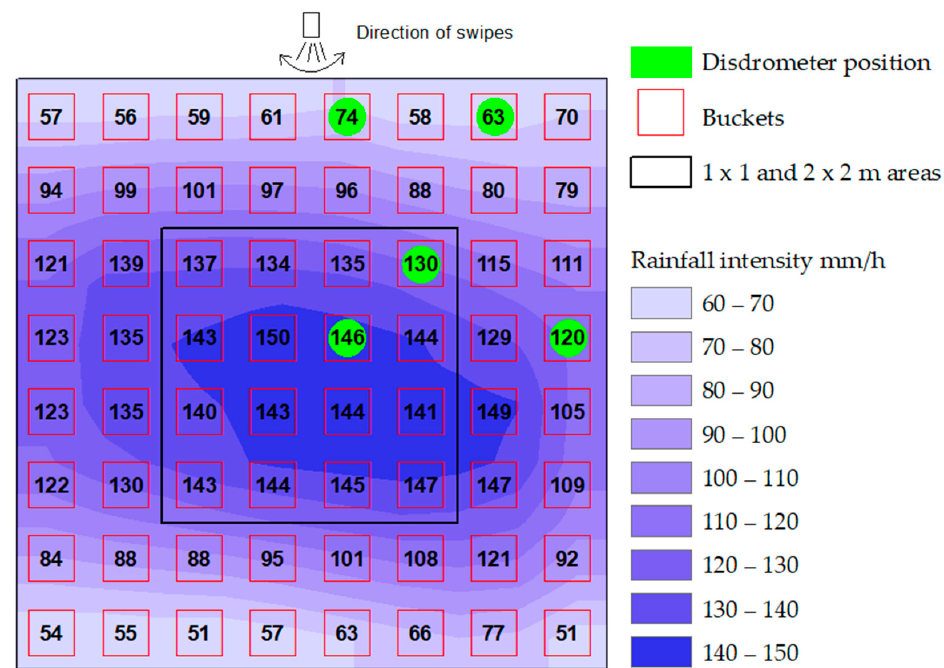
Figure 3. Example of rainfall spatial distribution for the nozzle Veejet 80100. The experiment was conducted without gaps. Presented is the maximal possible intensity for this nozzle. The numbers in the boxes indicate rainfall intensity in mm/h at the specified location. Table 1. List of tested nozzles. VJ—VeeJet nozzles provide a flat water jet. WSQ provide a square water jet. The nozzles marked with * are suitable for further use. The WSQ 40 nozzle was tested in a stationary position also with swipe. For VJ 9540 and VJ 9560 nozzles, Ke values were not measured, as the required uniformity of 70% was not achieved with these nozzles.